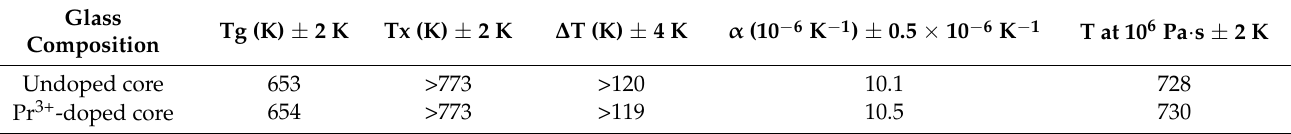
Table 1. Thermal characteristics of glasses corresponding to the undoped and Pr 3+ -doped cores,